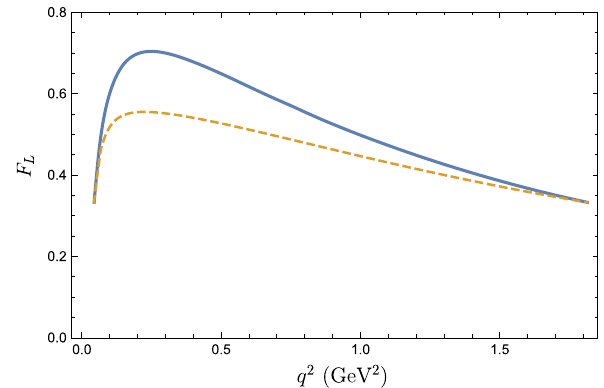
Fig. 3 The differential branching fractions for the (cid:2) c → p μ + μ − rare decay. The area between dashed-dotted (orange) curves corresponds to the nonresonant predictions, while the (green) band shows resonance contributions including uncertainties in coefficients a ρ and a φ as well as variations of the relative strong phases δ ρ and δ φ . The horizontal black line denotes the LHCb 90% CL upper limit [9]